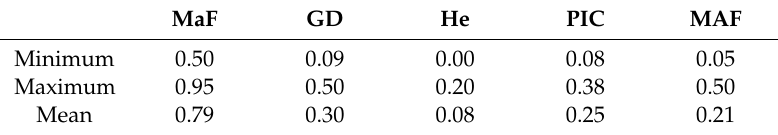
Table 3. Diversity statistics of the 162 maize inbred lines based on 9684 DArT single nucleotide polymorphism (SNP) markers. MaF GD He PIC